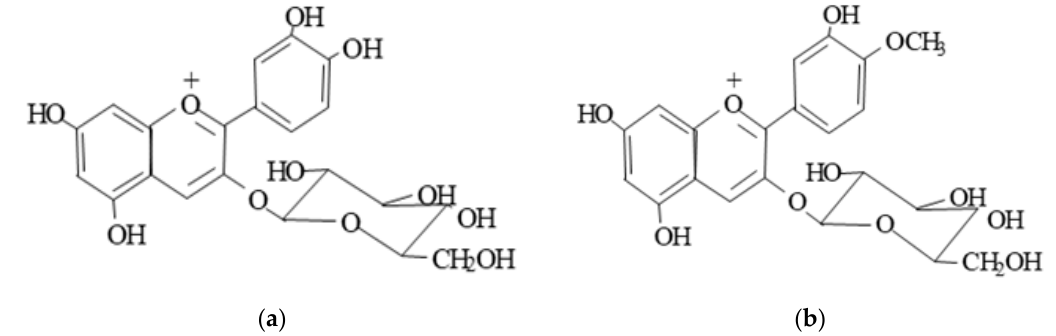
Figure 2. Structures of cyanidin-3- O -glucoside ( a ) and peonidin-3- O -glucoside ( b ).